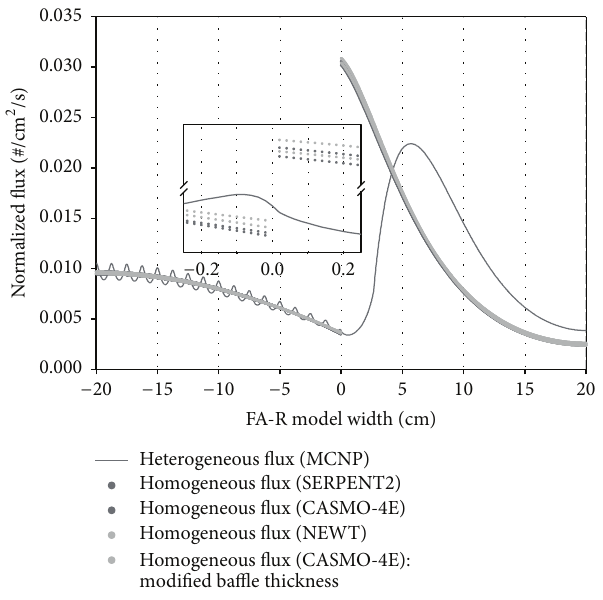
Figure 12: The thermal flux distribution and detail view at interface for FA-RB model.